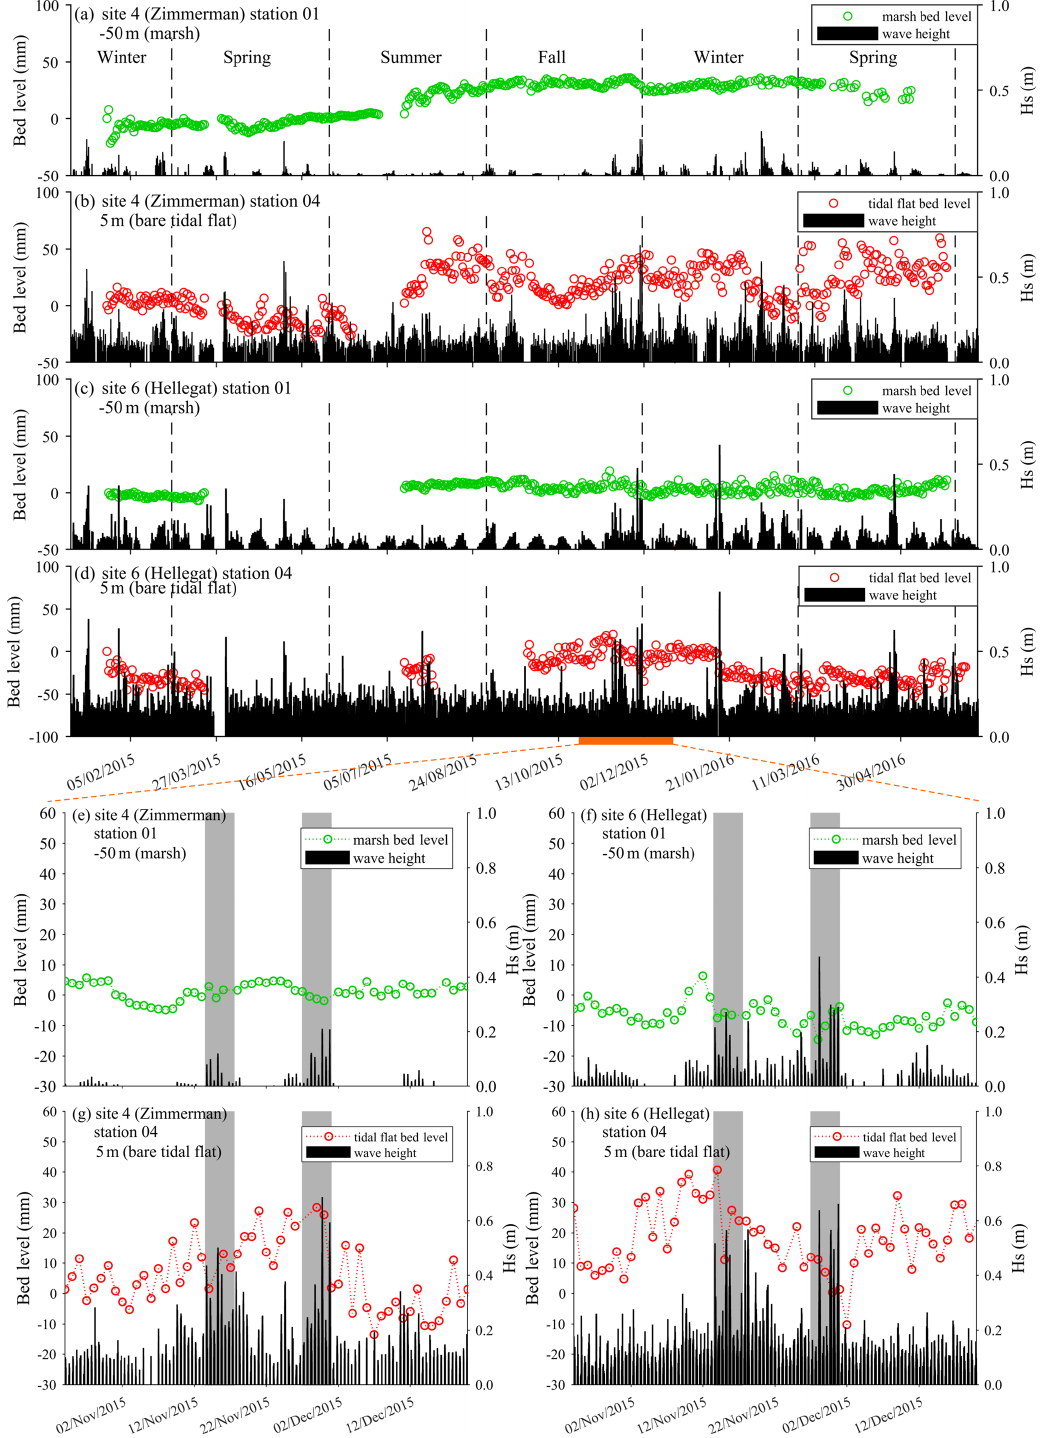
Figure 3. Time series of the bed-level change and significant wave height ( H s ) at site 4 (Zimmerman; a , b , e , g ) and site 6 (Hellegat; c , d , f , h ). The top four planes (a–d) are the entire dataset of four measuring stations from these two sites. Those of station 4 are on a bare tidal flat (5m seaward of the marsh edge), whereas those of station 1 are in the marsh (50m landward of the marsh edge). The gaps in the bed-level time series were due to temporary sensor failures. The lower four planes are the enlarged plots of the stormy period in November– December 2015. The dark grey shaded areas indicate bed-level changes during two storm events (13–17 November and 27 November–1 December